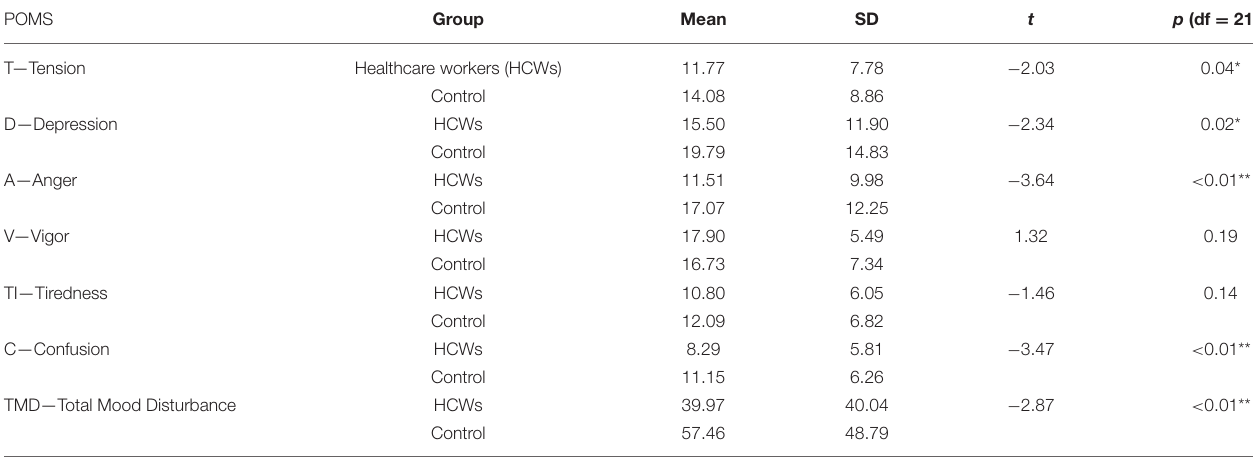
TABLE 1 | Means, t -test, and p -value for the comparison between groups in the factors and total score of Profile of Mood States (POMS). POMS Group Mean SD t